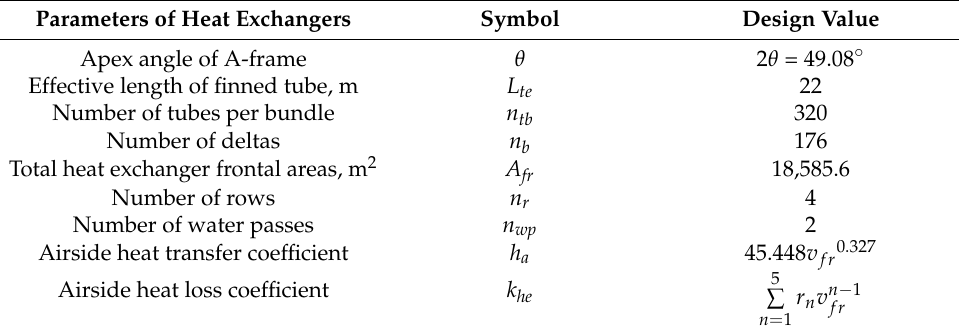
Table 1. Design parameters of heat exchangers.